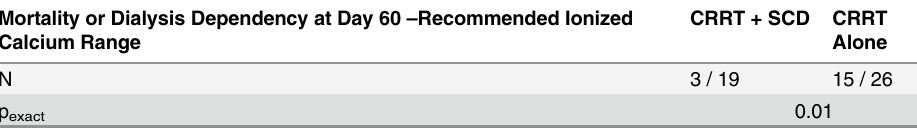
Table 8. Mortality or Dialysis Dependency at Day 60 – Recommended Ionized Calcium